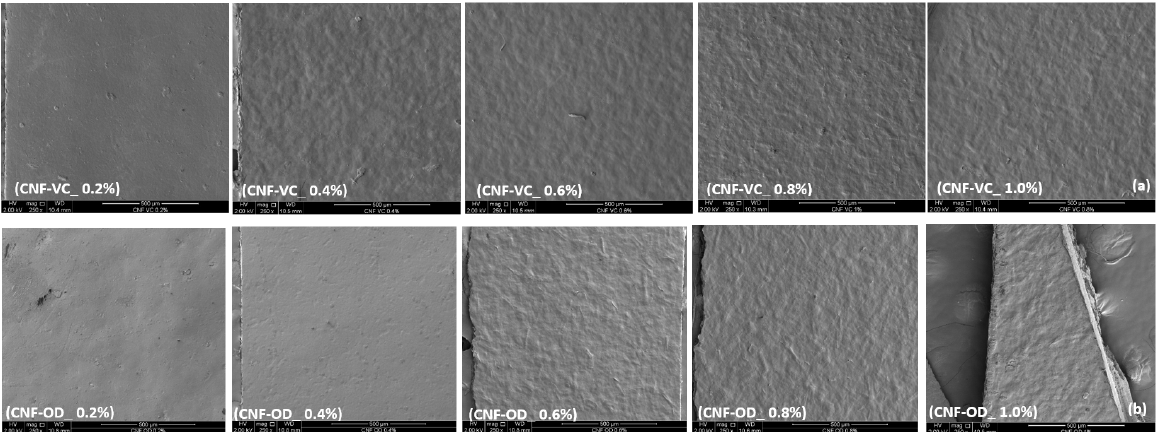
Figure 3. Effect of CNF concentration on surface morphology of ( a ) CNF-VC and ( b ) CNF-OD. The surface morphology of the films can provide additional information that can support the physical and mechanical properties of nanocellulose